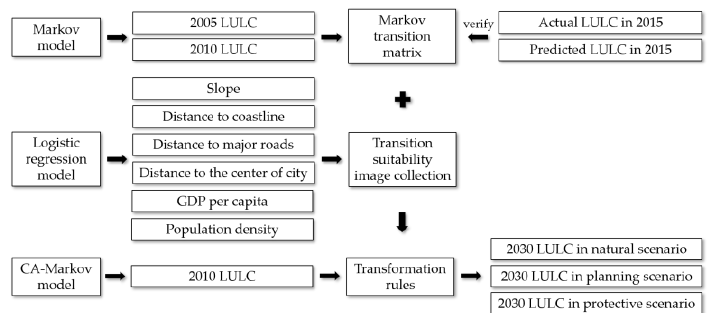
Figure 2. Workflow of Markov-Logistic-CA model. Table 4. Land use changes in Quanzhou during 2005 – 2015.